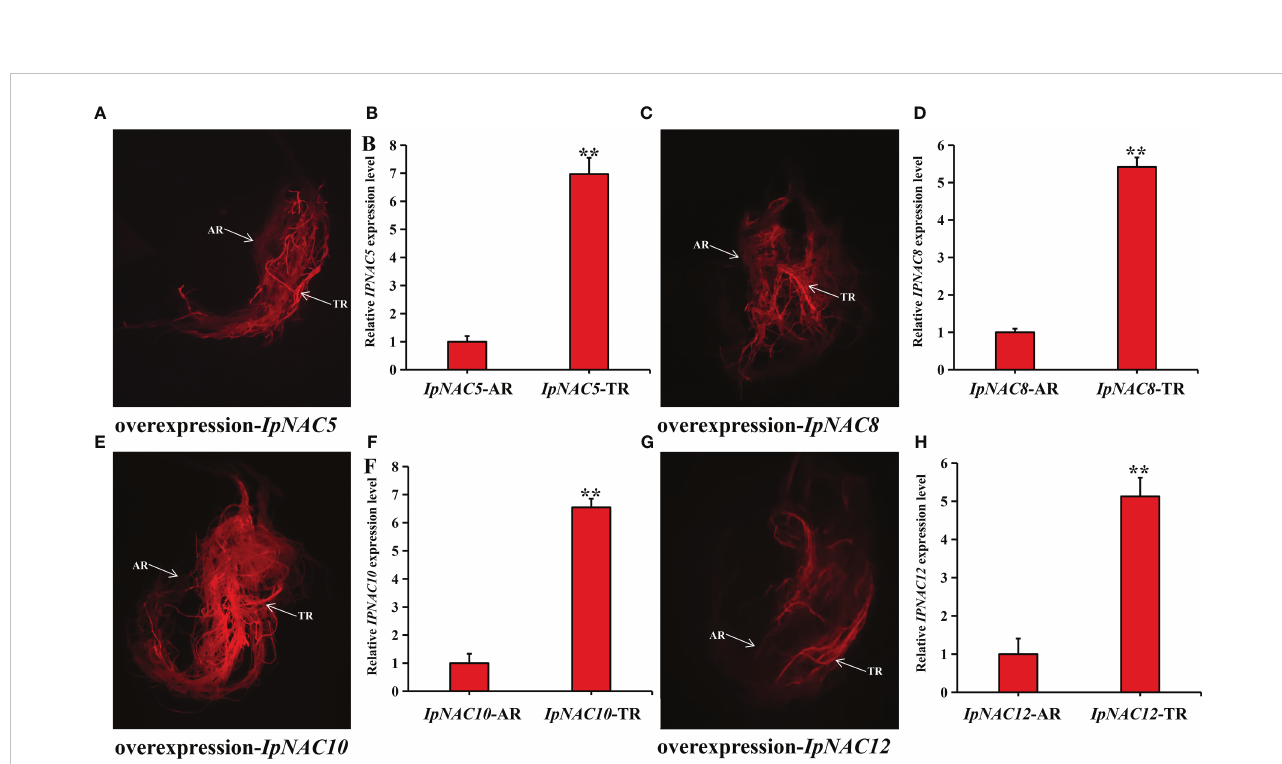
FIGURE 9 Preparation of IpNAC5/8/10/12 transgenic sweetpotato roots. (A, C, E, G) DsRed fl uorescence diagram of transgenic sweetpotato root. TR: positive transgenic roots; AR: non-transgenic roots. (B, D, F, H) Relative expression levels of IpNAC5/8/10/12 in TR and AR. Asterisks indicate the level of signi fi cance, ** p < 0.01 . Gene levels of AR were used as a reference and set as